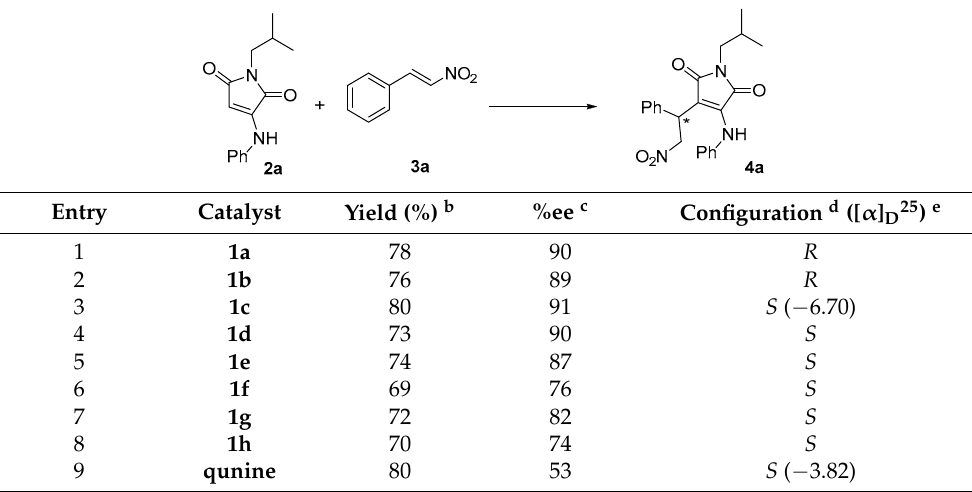
Table 1. Asymmetric Michael reaction of α -aminomaleimide with β -nitrostyrene catalyzed by 1a – h a . a